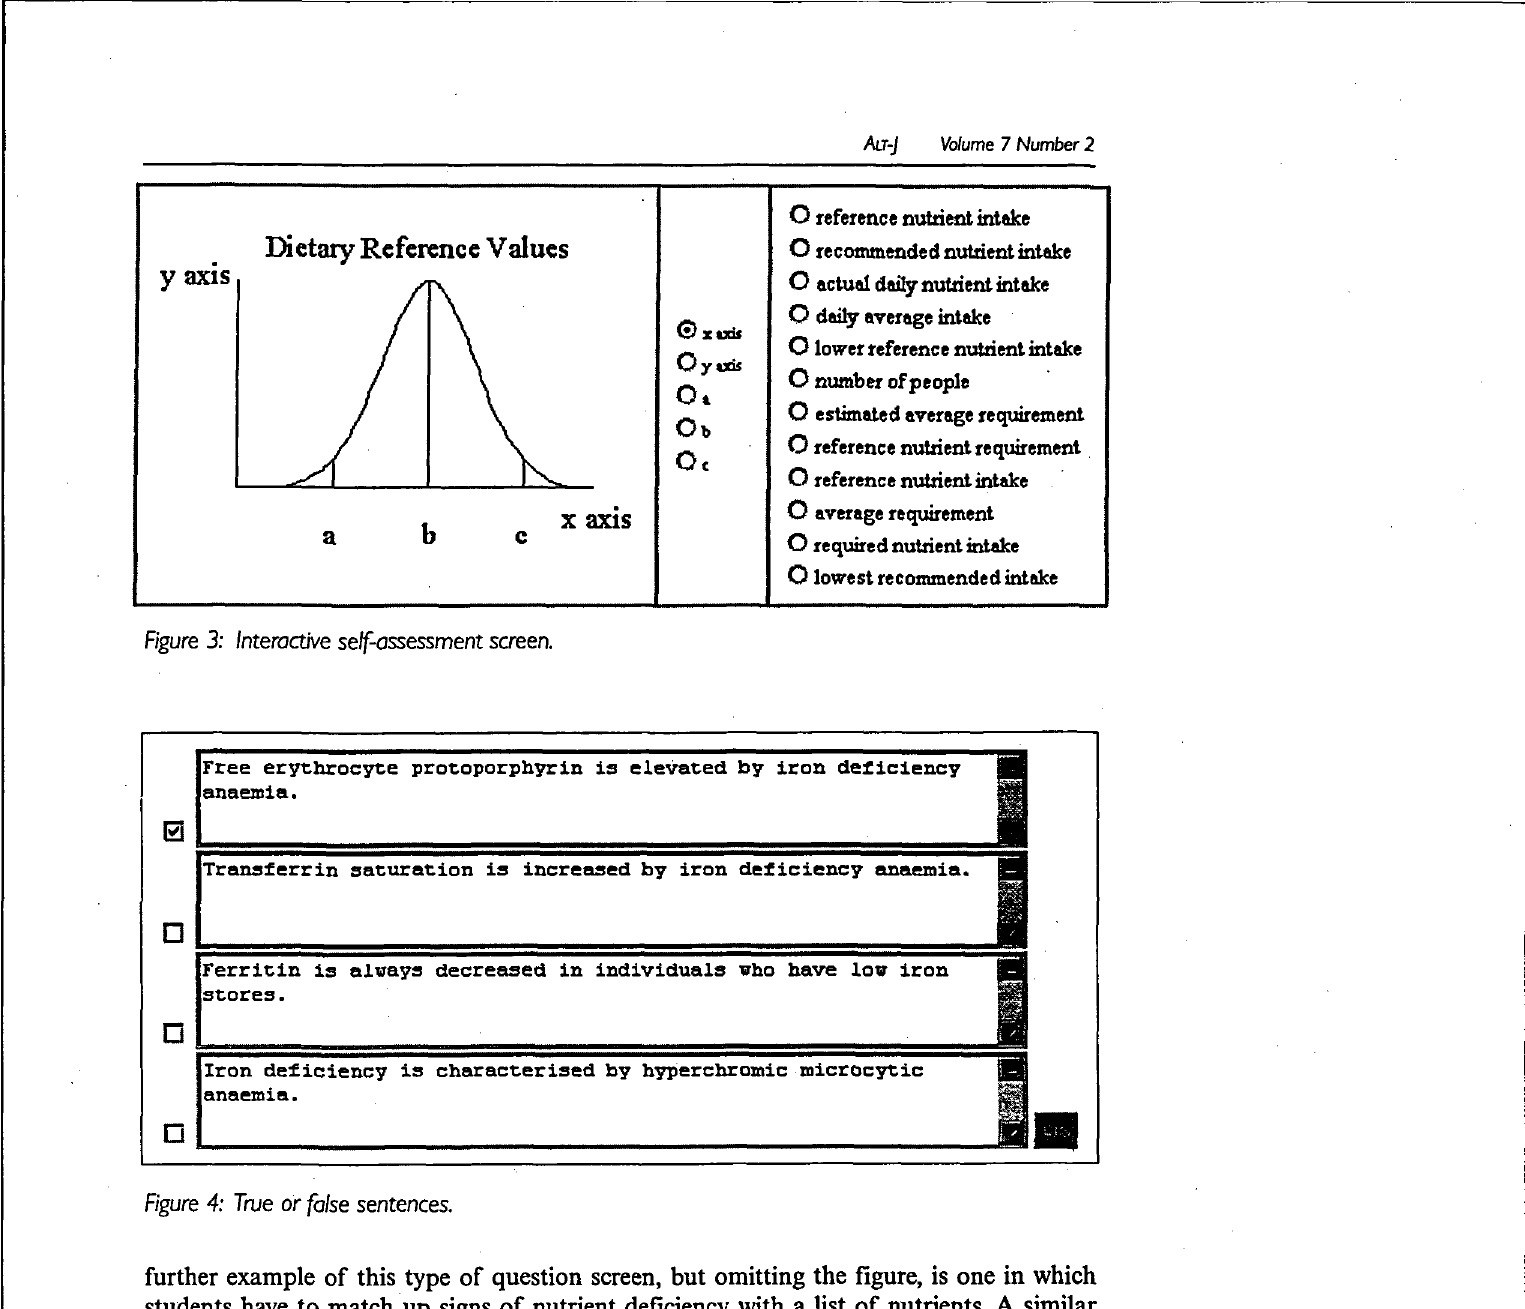
Figure 4: True or false